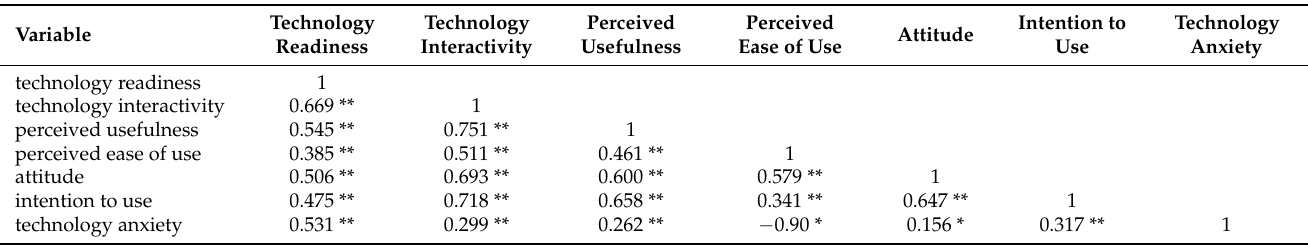
Table 4. Correlation analysis among